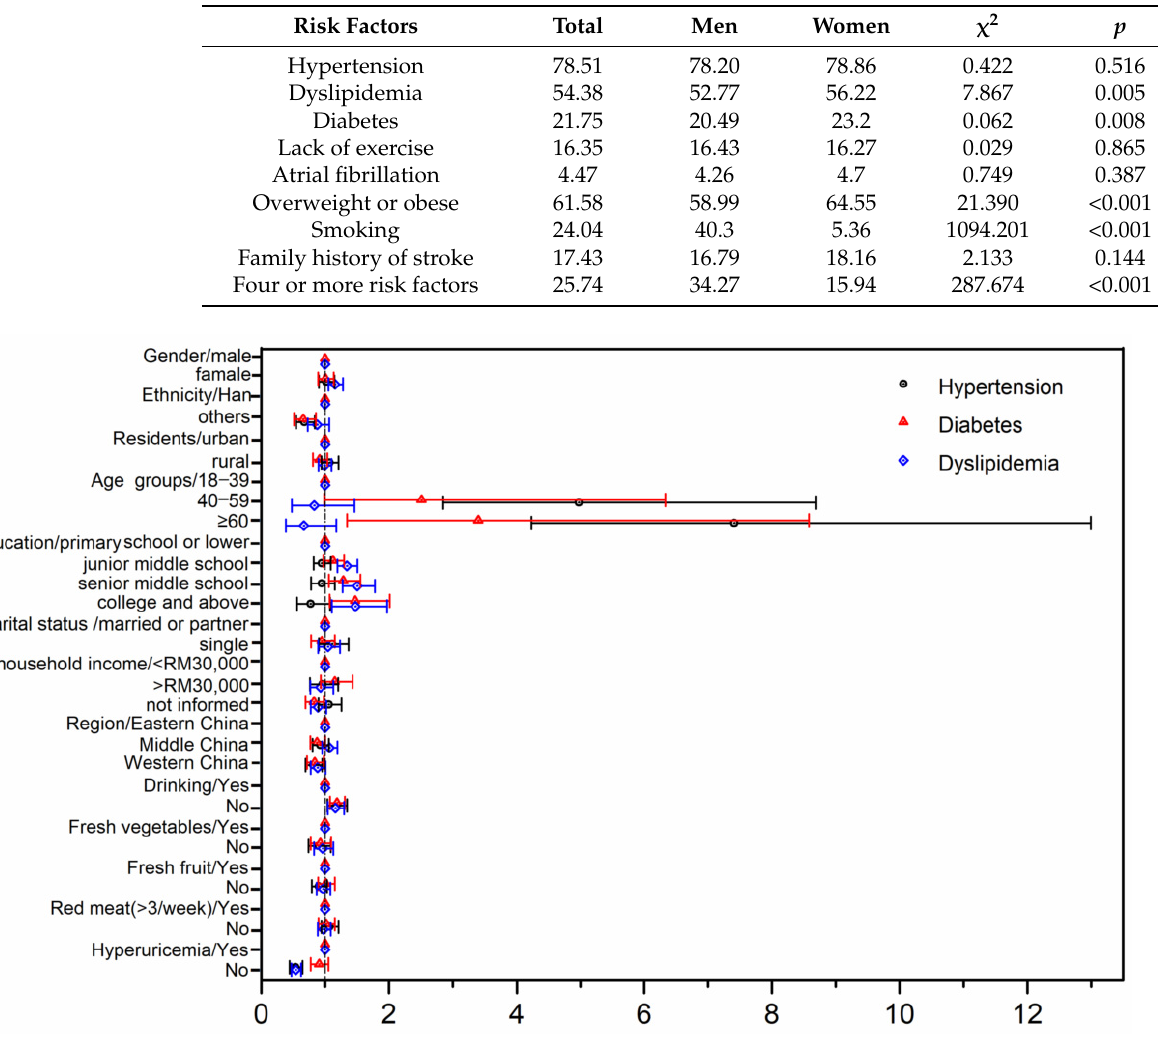
Figure 1. Adjusted (adjusted other different factors including gender, ethnicity, residents, age, marital status, and annual household income) odds ratios and 95% confidence intervals for hypertension diabetes dyslipidemia in different target groups. Table 3. Awareness, treatment, and control rate of hypertension, diabetes, and dyslipidemias in stroke patients in China